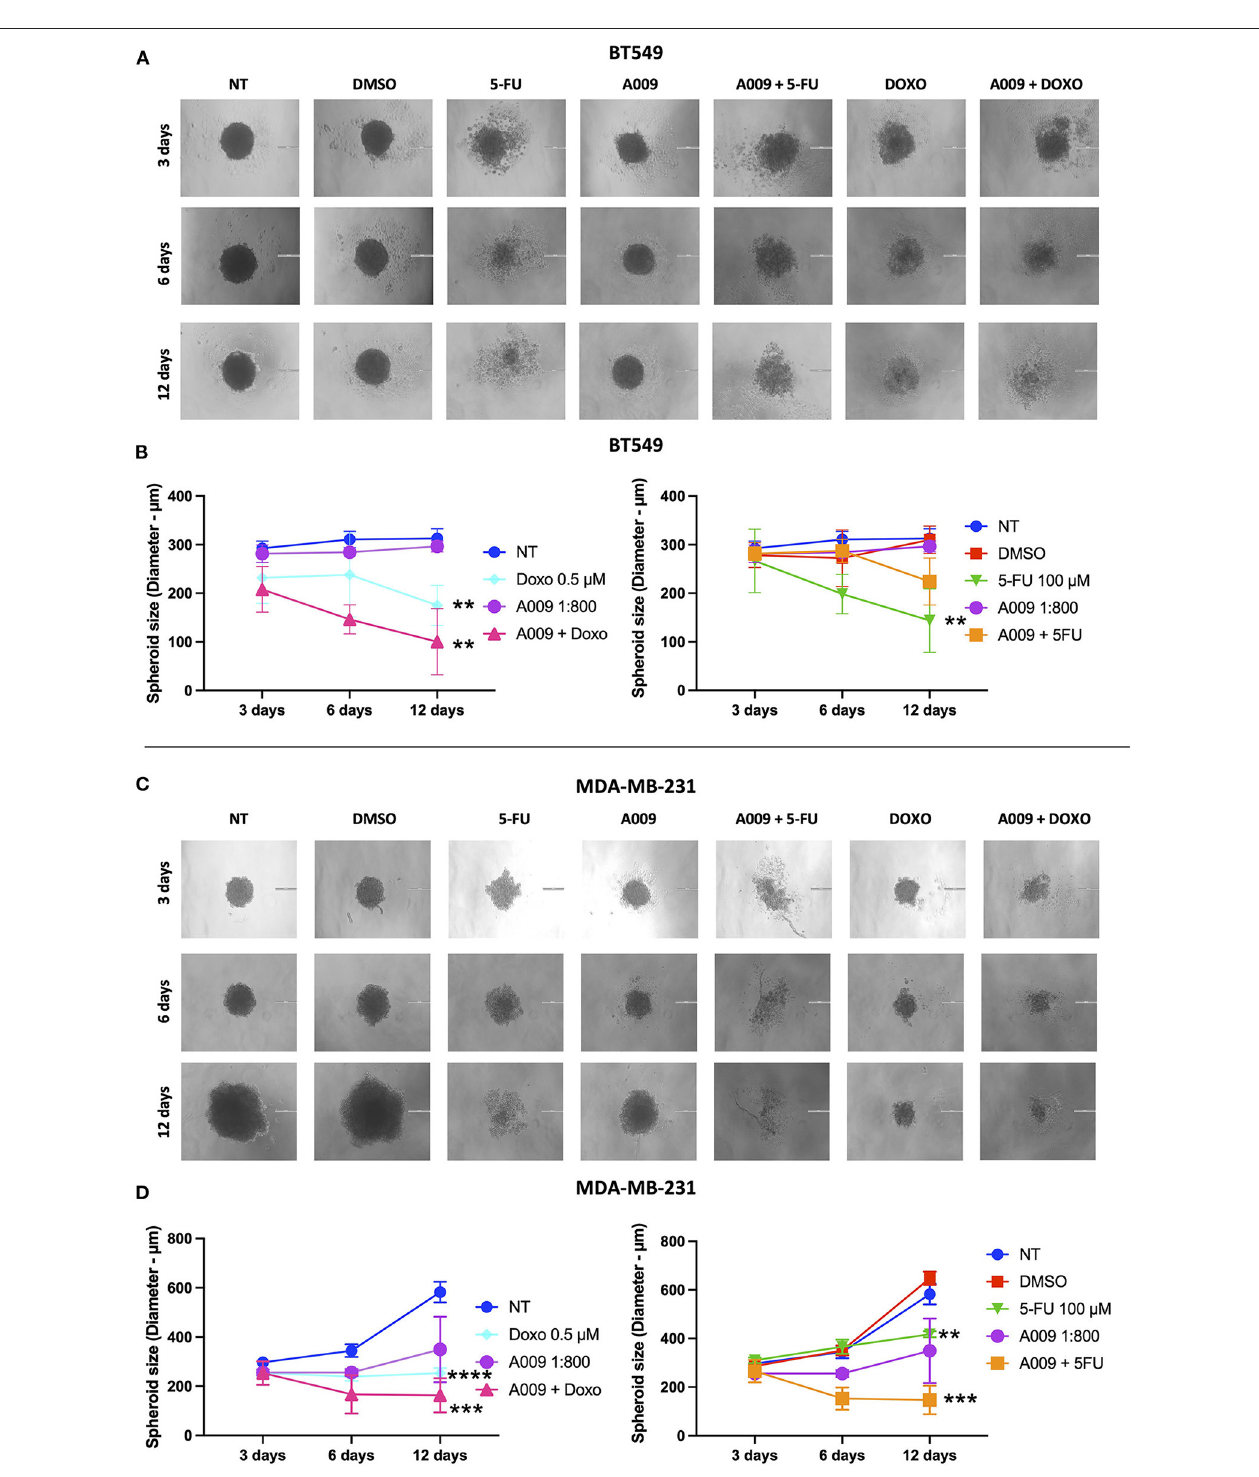
FIGURE 4 | Effects of the combination A009 chemotherapy on breast cancer spheroids. Single spheroids were generated by culturing 4 x 10 3 BT549 or + MDDA-MB-231 cells in nonadherent conditions. BT459 (A,B) and MDA-MB-231 (C,D) spheroids were treated with the combination of A009 extract 5-FU or Doxo, + A009 or drugs alone, for 3, 6, and 12 days. During the treatment kinetic, spheroid diameters were detected, and spheroid macrophotographs were captured. The experiments were performed in quadruplicate and repeated two times. Scale bar 200 µ m. Data are shown as mean SEM, two-way ANOVA, ** p < 0.01, *** p < = ± 0.001, and **** p < 0.0001. A009 combinations with chemotherapy reduced size of breast cancer cell spheroids.